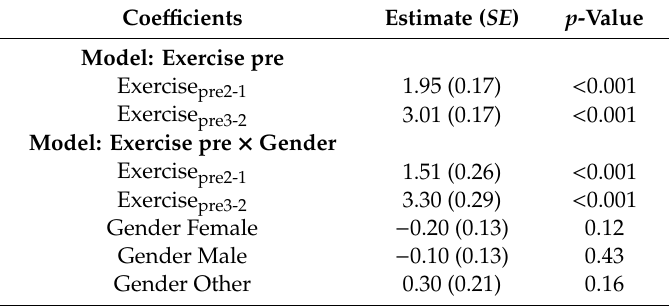
Table 3. Change in exercise behavior. Statistical results for the cumulative link models (CLM) predicting exercise frequency during a pandemic with prepandemic exercise frequency and di ff erent covariates in separate